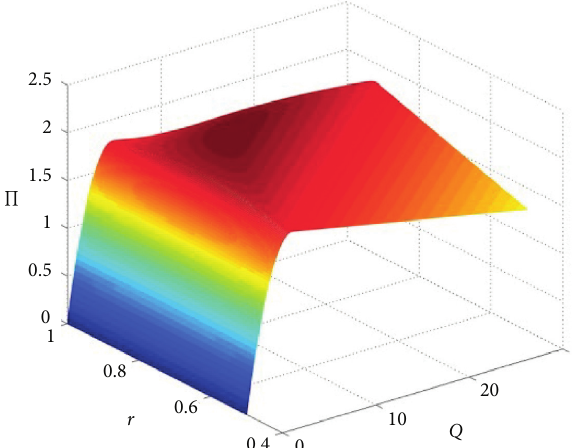
Figure 5: The influences of r and Q on the retailer’s profit.